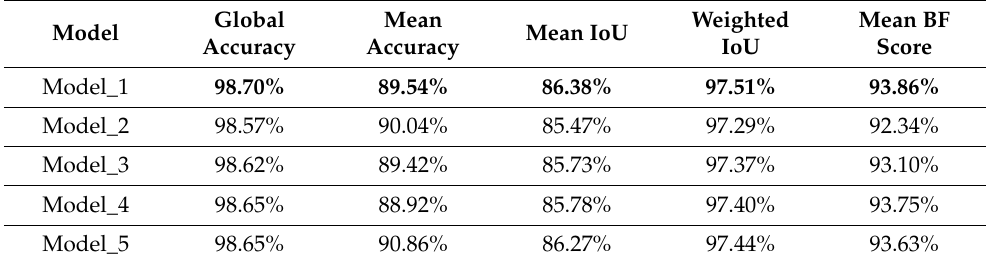
Table 5. Resume of performance of the selected models.